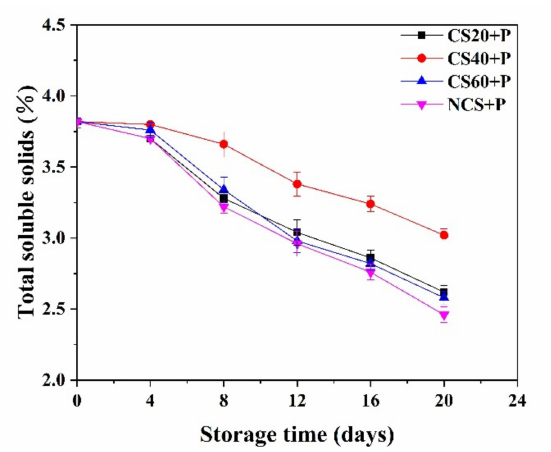
Figure 4. Effect of different treatments on the total soluble solids content of cucumbers during storage at 13 ± 2 ◦ C. CS20+P − packaged after 20 min of cold shock; CS40+P − packaged after 40 min of cold shock; CS60+P − packaged after 60 min of cold shock; NCS+P − packaged after 0 min of cold